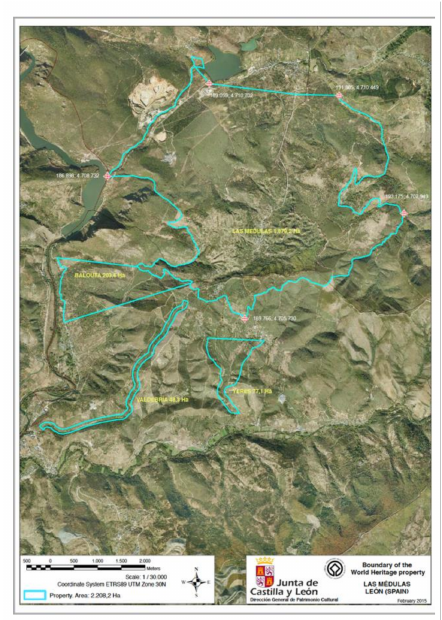
Figure 2. The M é dulas: exploitation and accumulation sectors. Source: Castilla y Le ó n Government.